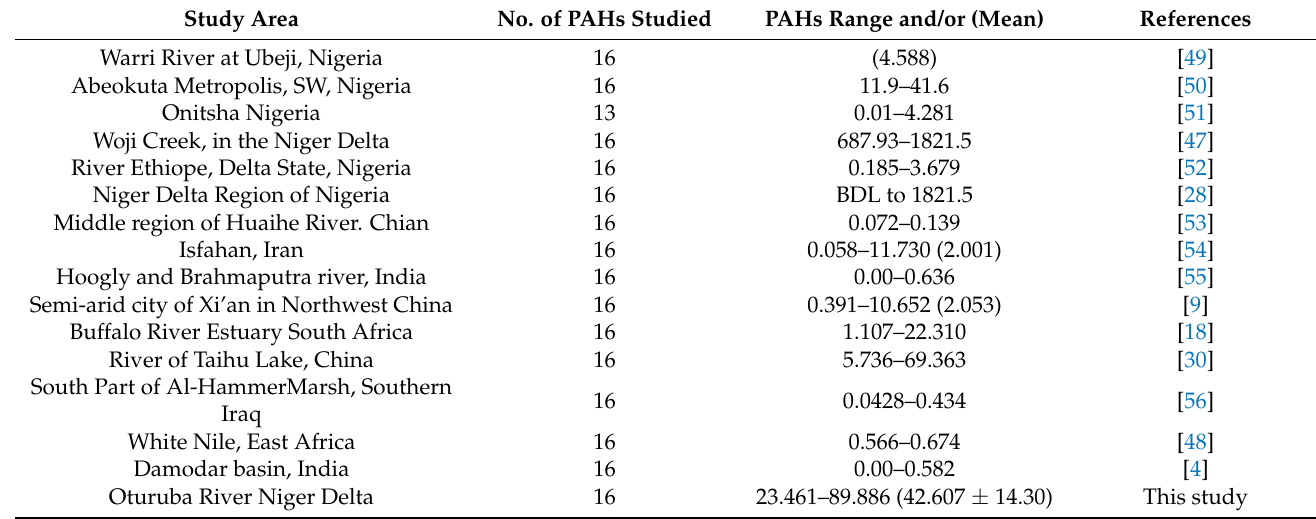
Table 3. Comparison of PAHs levels in sediments of this study with related studies (mg/kg). Study Area No. of PAHs Studied PAHs Range and/or